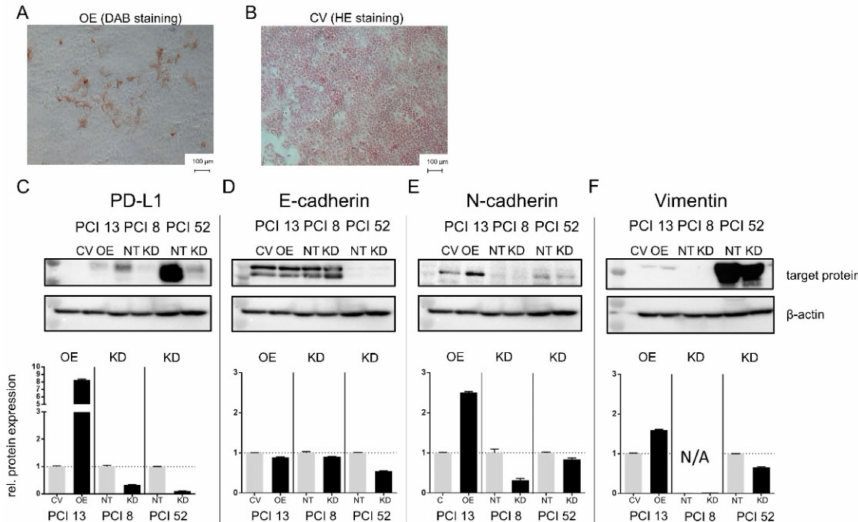
Figure 1. PD-L1 dependent expression of EMT markers. ( A ) Programmed cell death ligand-1 (PD-L1)-dependent expression of epithelial-to-mesenchymal transition (EMT) markers in 3D cultured cells may lead to morphological changes. PD-L1 overexpression in the head and neck squamous cell carcinoma (HNSCC) cell line PCI 13 with low intrinsic PD-L1 expression. Immunocytochemical staining reveals that PD-L1 overexpression resulted in cells with an elongated spindle-shaped morphology in contrast to cells transfected with the empty control vector cells ( B ). ( C – F ) Western blot analysis of PCI 13 after PD-L1 overexpression (OE) and PCI 8 / PCI 52 after PD-L1 knockdown (KD). E-cadherin expression and expression of the mesenchymal markers N-cadherin and Vimentin are associated with PD-L1 expression. Lower lane: semiquantitative evaluation of Western blots for relative protein expression. Treated cells were normalized to their respective control. For Western blot analysis, 30 µ g total protein lysate was used. β -actin served as a loading control. The results are expressed as means ± SD (standard deviation) for two experiments. CV = cells transfected with the empty control vector, OE = cells transfected with a vector containing the coding sequence for PD-L1, NT = cells transfected with nontargeting small interfering ribonucleic acid (siRNA) control, KD = knockdown cells transfected with siRNA against